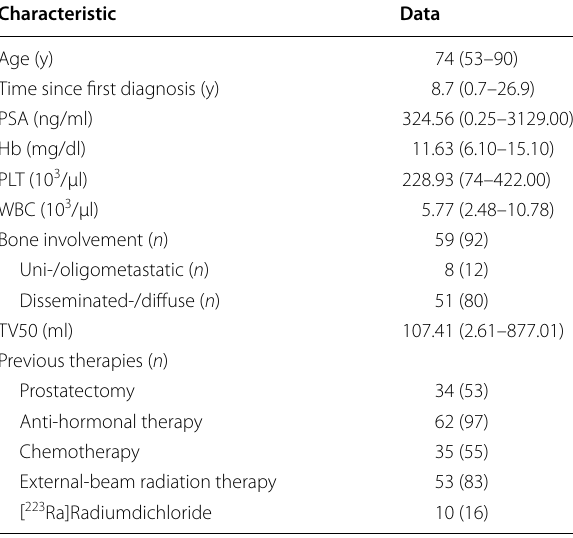
Table 1 Patient characteristics at Baseline ( n